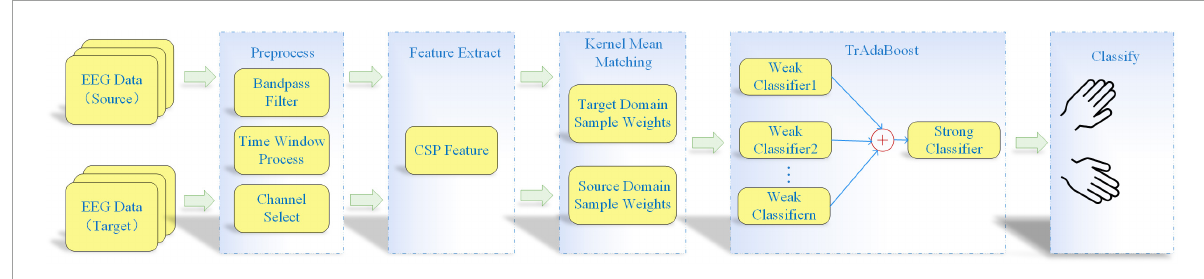
FIGURE1 Flow chart of kernel mean matching-transfer learning adaptive boosting (KMM-TrAdaBoost) algorithm.